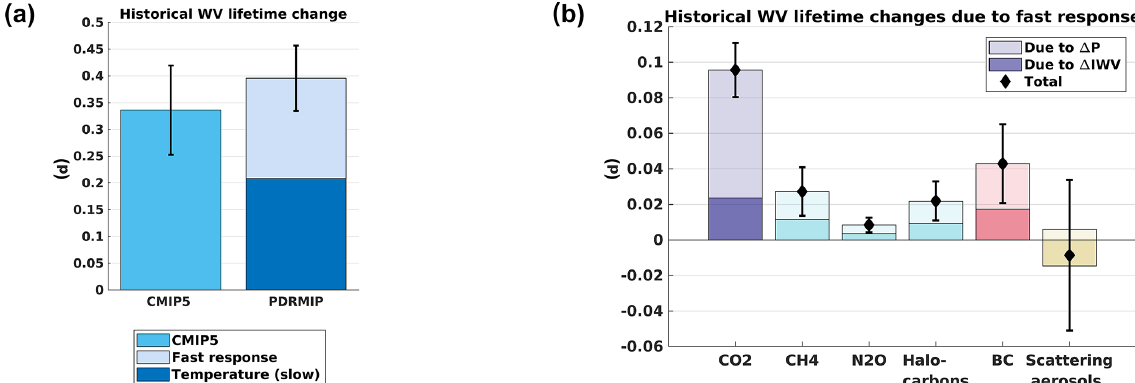
Figure 6. Contributions to historical water vapour lifetime change. (a) Total historical change in water vapour (WV) lifetime from CMIP5 models compared to PDRMIP results with contributions from slow and fast responses. (b) Historical WV lifetime change due to fast re- sponses, split into different drivers and into contributions from changes in precipitation (light-coloured bars) and IWV (dark-coloured bars). Error bars show the standard deviation representing the spread between the